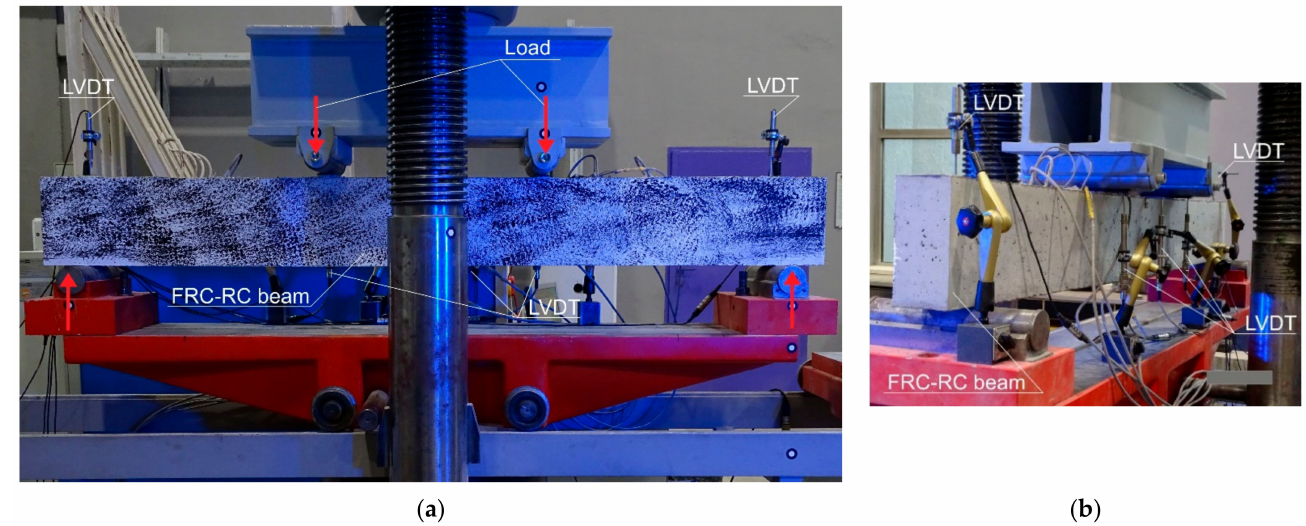
Figure 6. FRC-RC beams during the four-point test: ( a ) front view; ( b ) back view. During the tests, the strains of the longitudinal bottom bars were measured. The strain of the beam surface was measured in the compression and tension zones. The strain gauges were glued to the beam—its arrangement is schematically presented in Figure 4. In the RC beams, the strain gauges were also placed on the side surface at the depth corresponding to the location of the longitudinal bars. The deflection of the beam in the middle and under the points where the load was applied were measured using LVDTs. The support positions were also controlled by the LVDTs. The deformation of the almost whole front surface of the beam was monitored by the Digital Image Correlation (DIC)